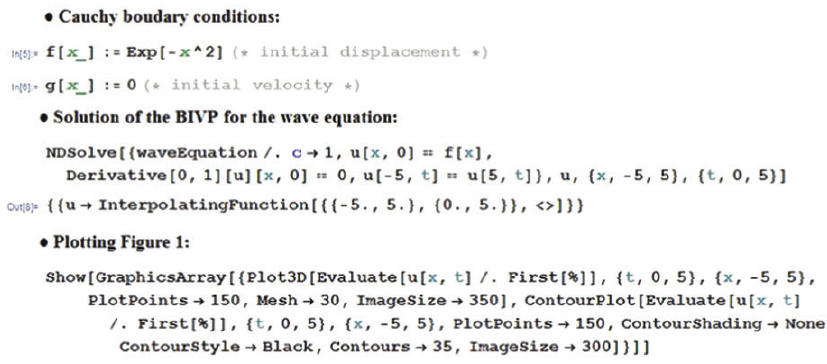
Figure 8 Mathematica ® primitives for solving the wave equation BIVP.